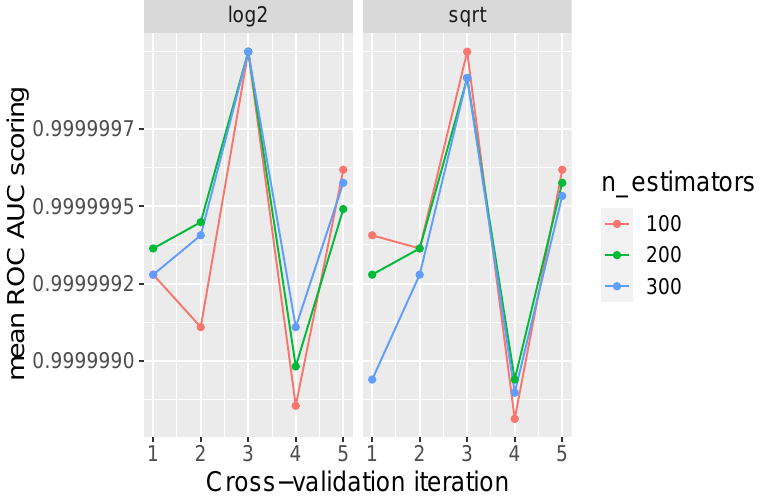
Figure 5. Random forest mean score by iteration.